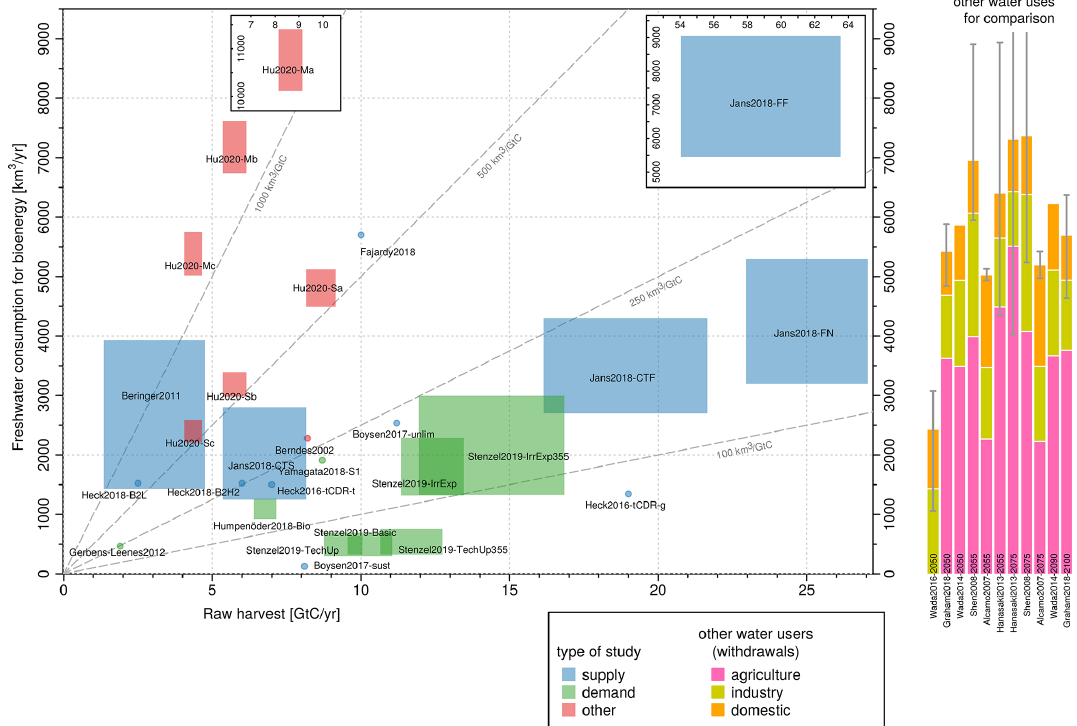
Figure 2. Overview of scenarios of reported values of global blue water consumption required for bioenergy production through biomass plantations (inlays show scenarios outside the plotting region). Scenarios are characterized by freshwater consumption for bioenergy plotted against raw harvest (inferred from reported biomass based energy or negative emissions). They can provide ranges in water withdrawals or raw harvest (illustrated by boxes) or contain single values (depicted by circles). The type of study is marked by the colour. Results for studies that report blue water withdrawals can be found in Fig. A2 and studies of green water consumption in Fig. A3. For contextualization, projections for other water uses (withdrawals) are shown to the right together with their uncertainty ranges. Names of the bioenergy scenarios are constructed as {author}{publication year}–{scenario name} and those of “other water use” scenarios as {author}{publication year}– {simulation